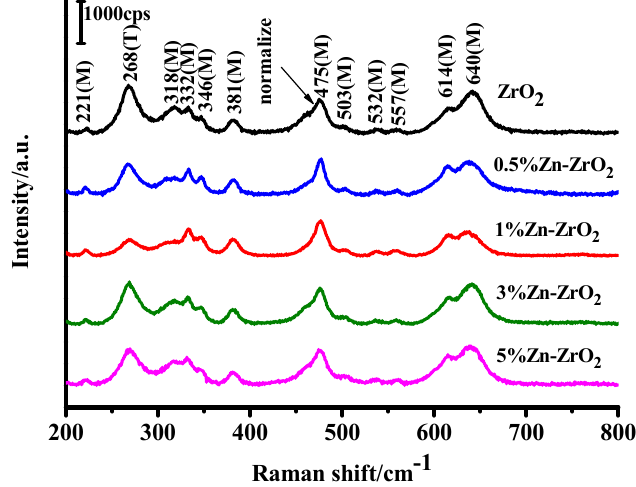
Figure 4. Raman spectra of the ZrO 2 and Zn–ZrO 2 (0.5–5%) samples.